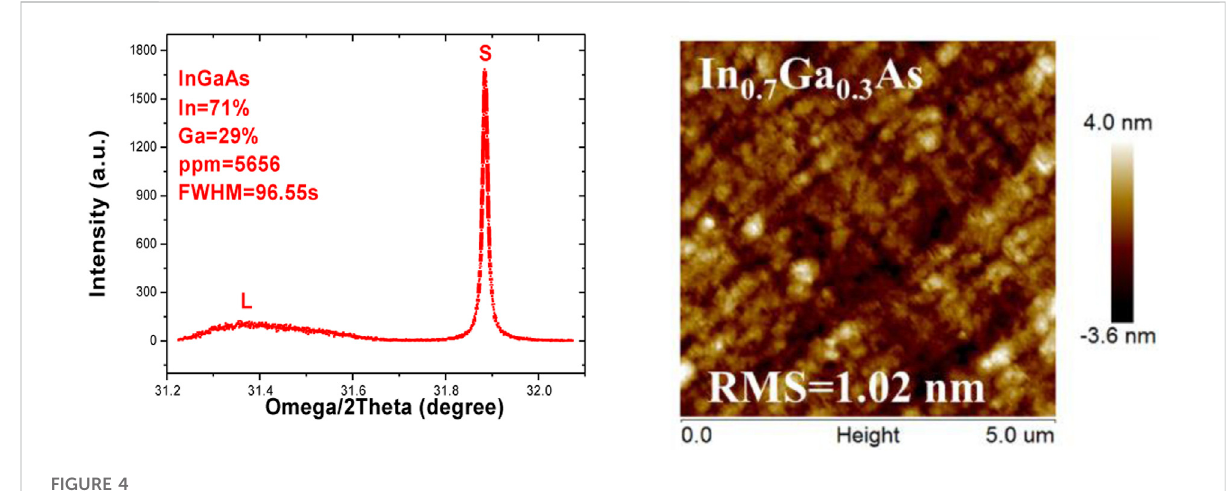
FIGURE 4 AFM images of In x Al 1-x As graded buffer layer with different thickness.